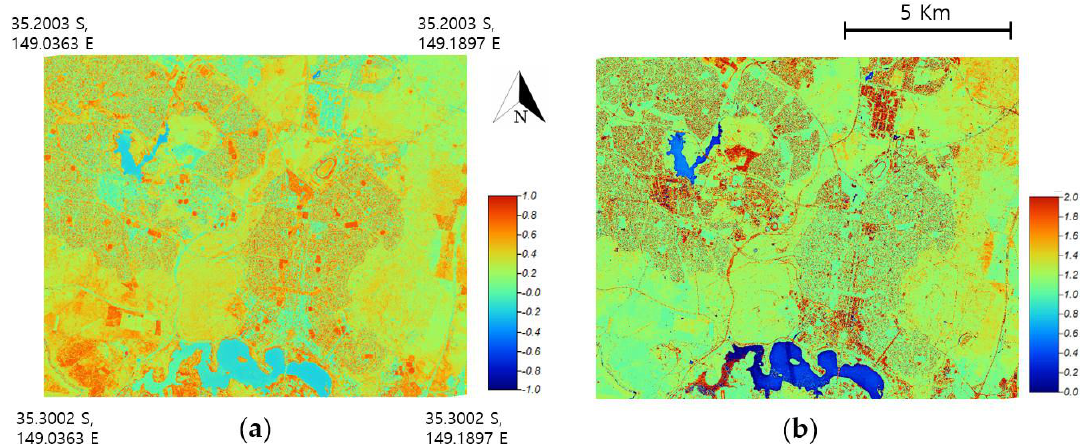
Figure 7. Vegetation indices obtained from the surface reflectance product of a KOMPSAT-3A image and AERONET data: ( a ) ARVI; ( b ) SIPI.